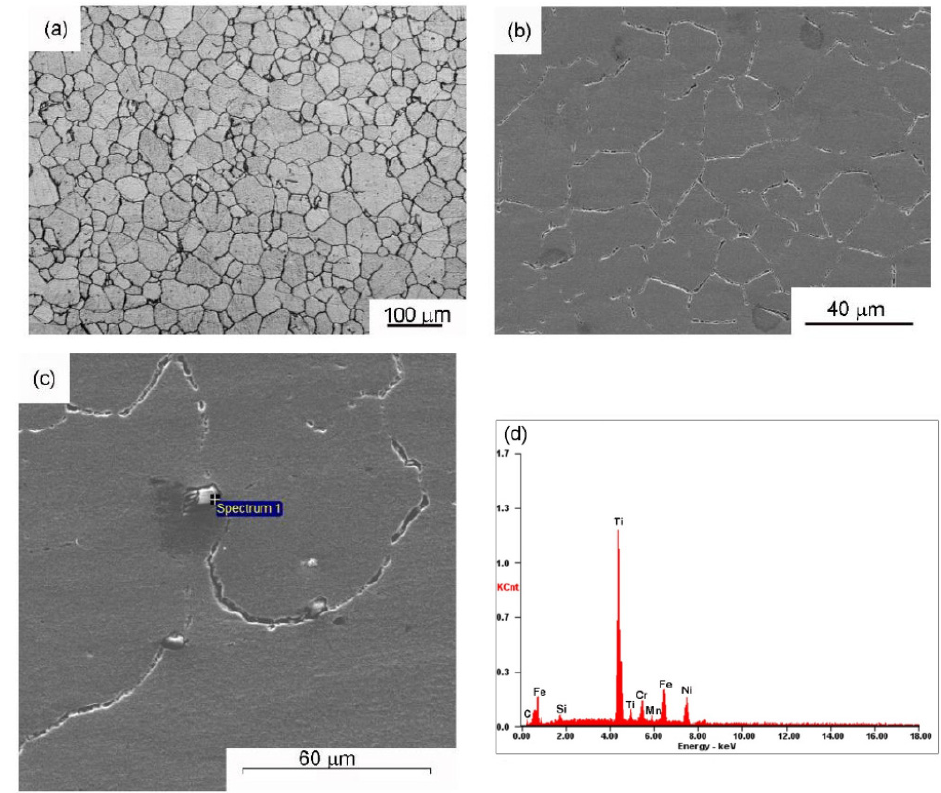
Figure 1. ( a ) Optical micrograph of the alloy 800H base metal, ( b ) secondary electron micrograph of the alloy 800H base metal, ( c ) SEM micrograph showing Ti-based precipitates, and ( d ) a typical EDS spectrum of